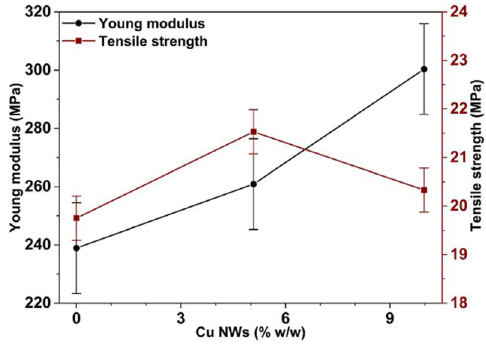
Figure 6. Effect of Cu NWs content on Young’s modulus ( • ) and tensile strength ( ■ ).